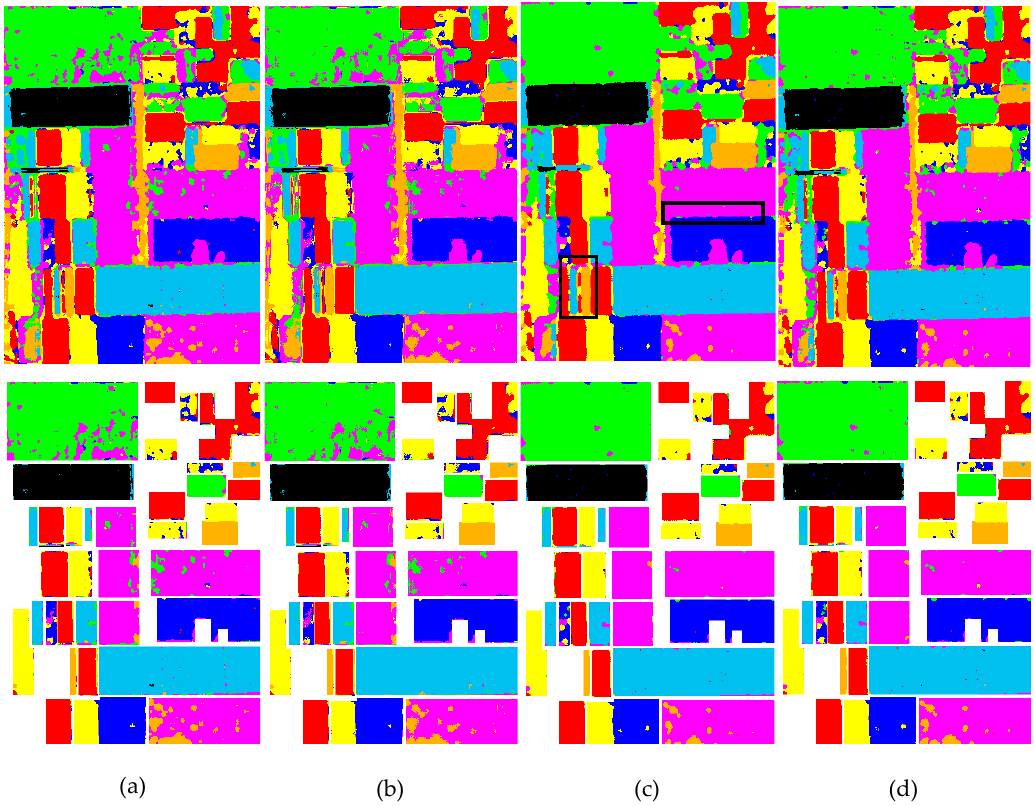
Figure 5. Pixel-based classification results of the Flevoland data. The first row shows the classification results, and the second row shows the corresponding classification results where the ground-truth map exists. ( a ) Wishart-MRF (WMRF). ( b ) K-Wishart-MRF (KMRF). ( c ) Wishart-MRF (MWMRF). ( d ) MWMRF model without the edge penalty term (MWMRF /